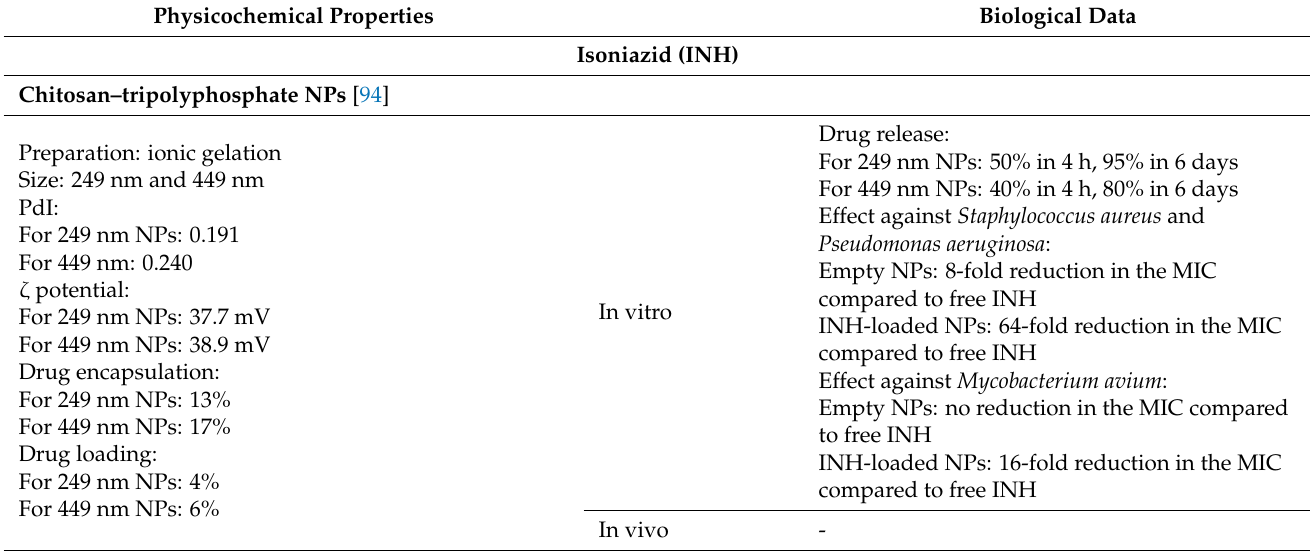
Table 1. Overview of the publications dedicated to the encapsulation of first-line antitubercular drugs, ranked by active molecule and by chronological order. PdI: polydispersity index; drug encapsulation: quantity of encapsulated molecule compared to the quantity of molecule used during the preparation of nanovectors, expressed as a percentage; drug loading: mass of encapsulated molecule compared to the total mass of nanovectors, expressed as a